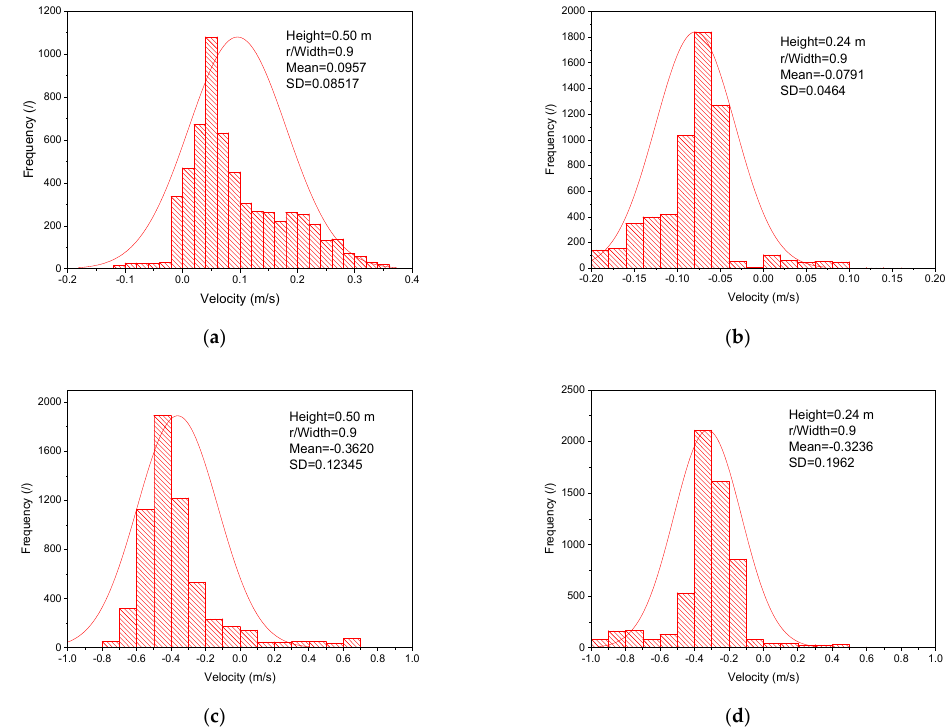
Figure 9. Histograms of wall axial and lateral velocities of particles used in experiment at the height of 0.24 m and 0.5 m, r/Width = 0.9, ρ p = 2700 kg/m 3 . ( a ) lateral velocity, 0.5 m; ( b ) lateral velocity, 0.24 m; ( c ) axial velocity, 0.5 m; ( d ) axial velocity, 0.24 m. Fig ure 10 displays the comparisons of the averaged axial velocities of particles with density of ρ p = 2700 kg/m 3 and ρ p = 800 kg/m 3 at the height of 0.24 m and 0.5 m. The axial velocities of EG particles are far greater than those of heavy particles, although the ratio of ultralight density to heavy particles is only 1/3 times, representing the serious particle back-mixing and circulation behaviors in the bed. This implies that the distribution of particle velocity is sensitive to particle density.